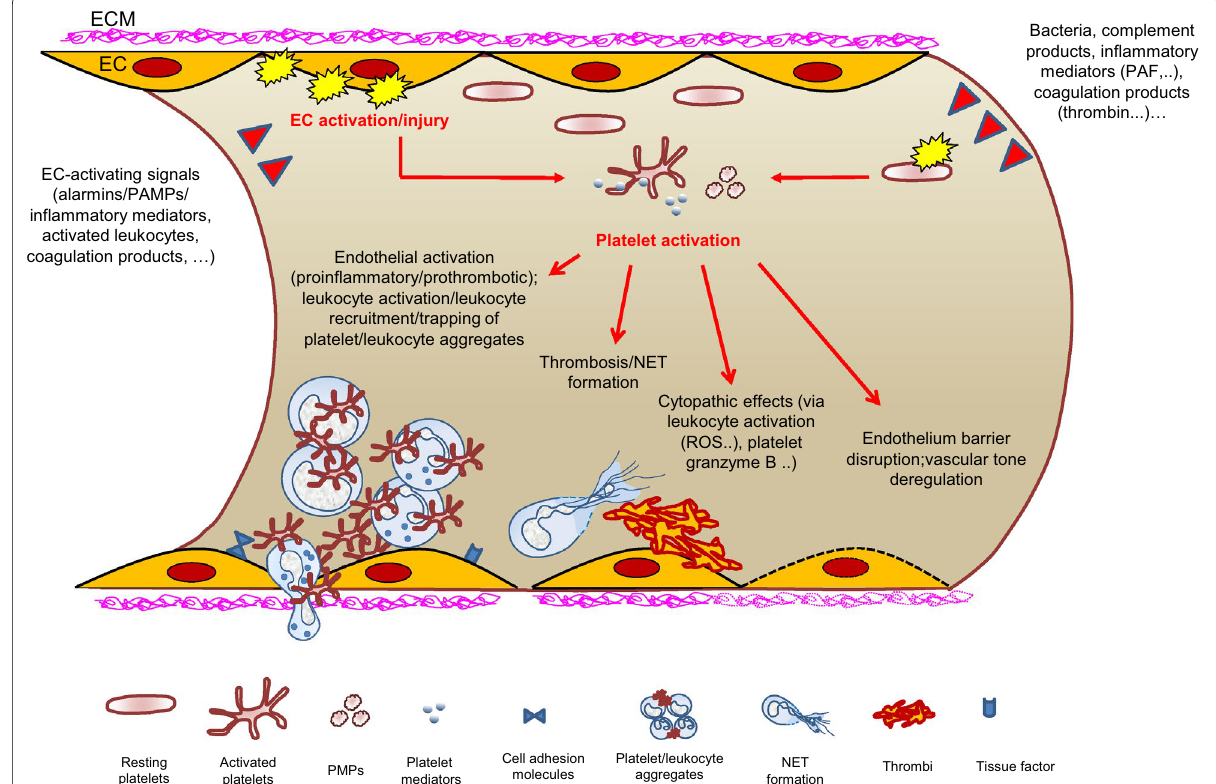
Fig. 3 Microvasculature is a critical target of platelet activation in sepsis. Platelets circulate more concentrated close to the vascular wall and sense endothelium disturbances. In sepsis, many cellular and soluble actors concur to activate the endothelium. Activated/injured endothelium is a key driver of platelet activation. Signals generated by infection, inflammation and coagulation can also activate platelets in sepsis. The relative importance of platelet activation by PAMPs in sepsis is not well established. Platelet activation contributes to fuel various pro-inflammatory and pro-coagulant pathways with potential deleterious consequences on endothelium homoeostasis and integrity. Unmitigated platelet activation in sepsis may take a significant part in the complex global scenario that leads to impairment of the endothelium barrier and microcirculatory failure, a leading cause of organ dysfunction in sepsis. Only some pathophysiological events are schematized (see text for details). Scales are arbitrary. ROS reactive oxygen species, EC endothelial cells, NET neutrophils extracellular traps, PMPs platelet microparticles, ECM extracellular